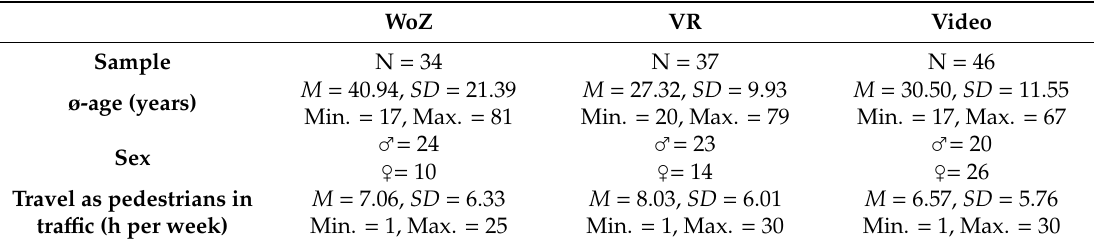
Table 1. Samples for all study